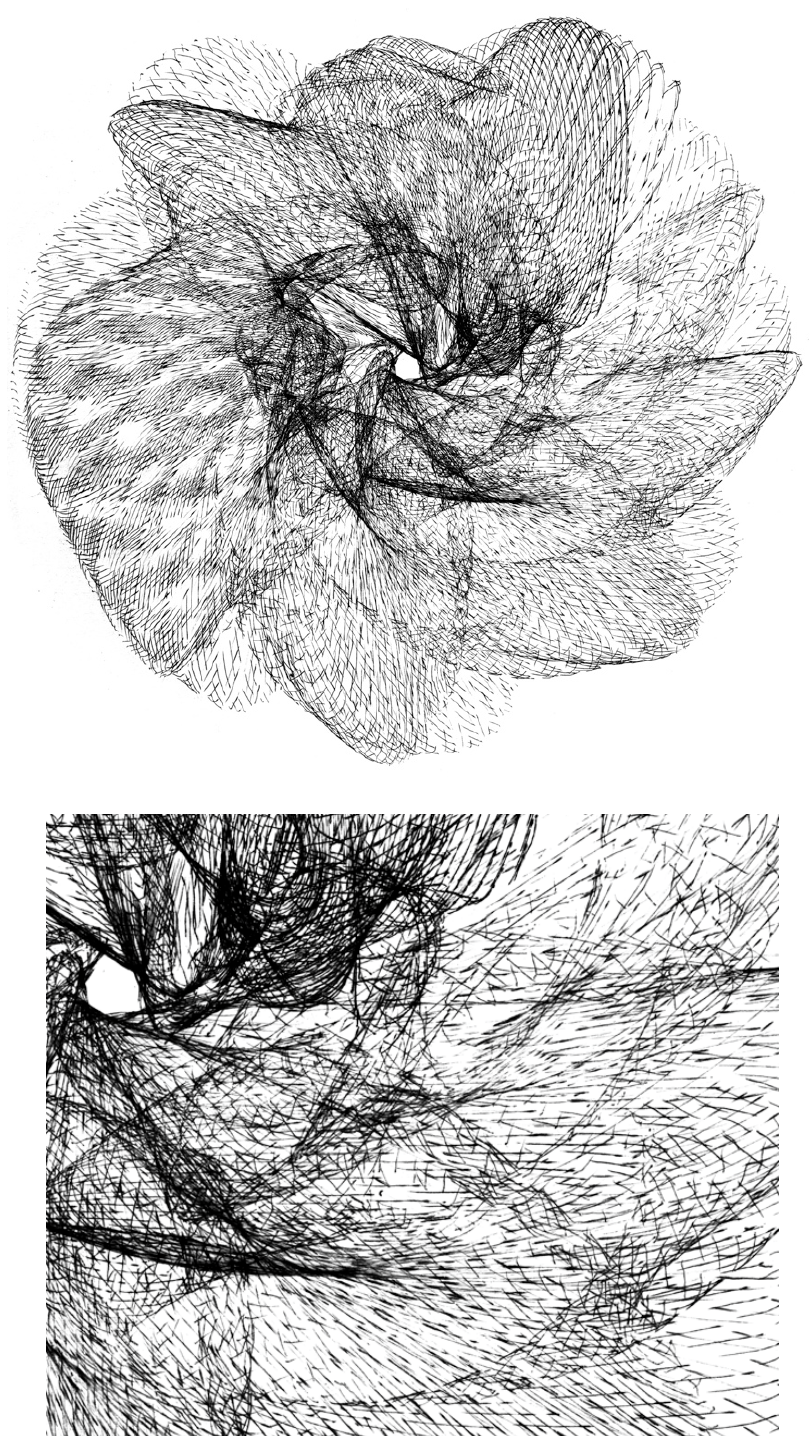
Figure 10. NTT image beginning to display characteristics nearer to a chaotic state.